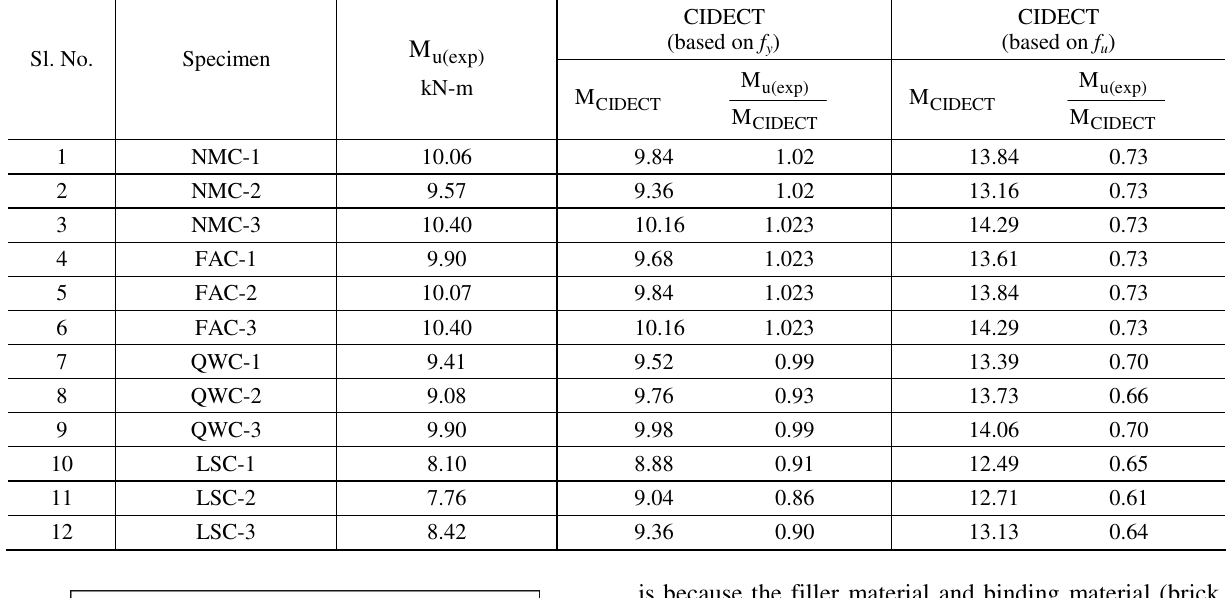
Table 7. Comparison of experimental and CIDECT standard values